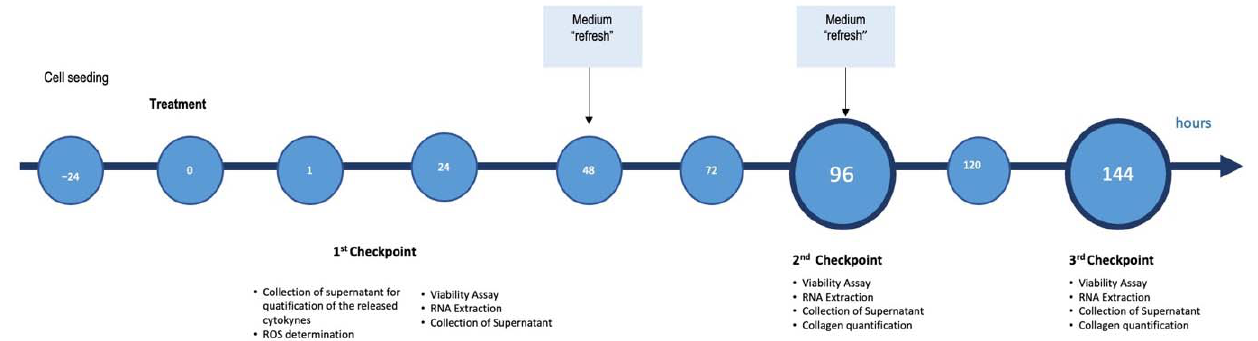
Figure 8. Scheme of the culture proceedings and the experimental checkpoints with the relative determinations.